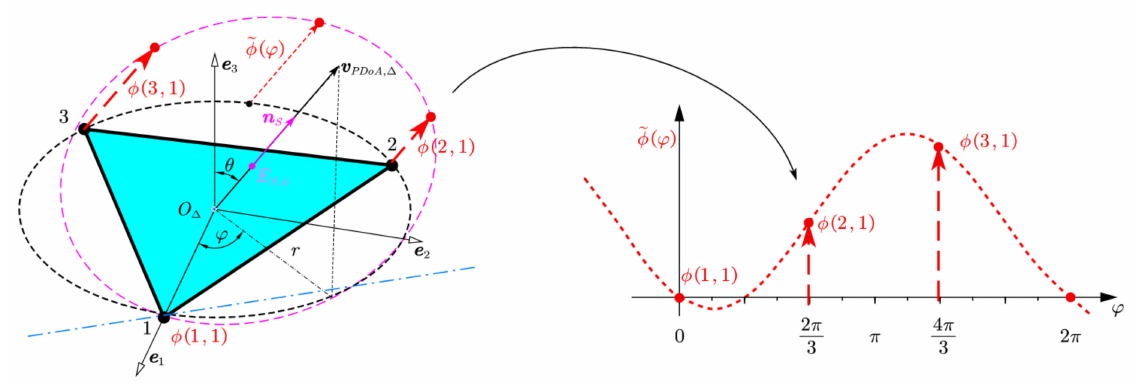
Figure 3. The visualization of actual phase difference φ ( i ,1 )